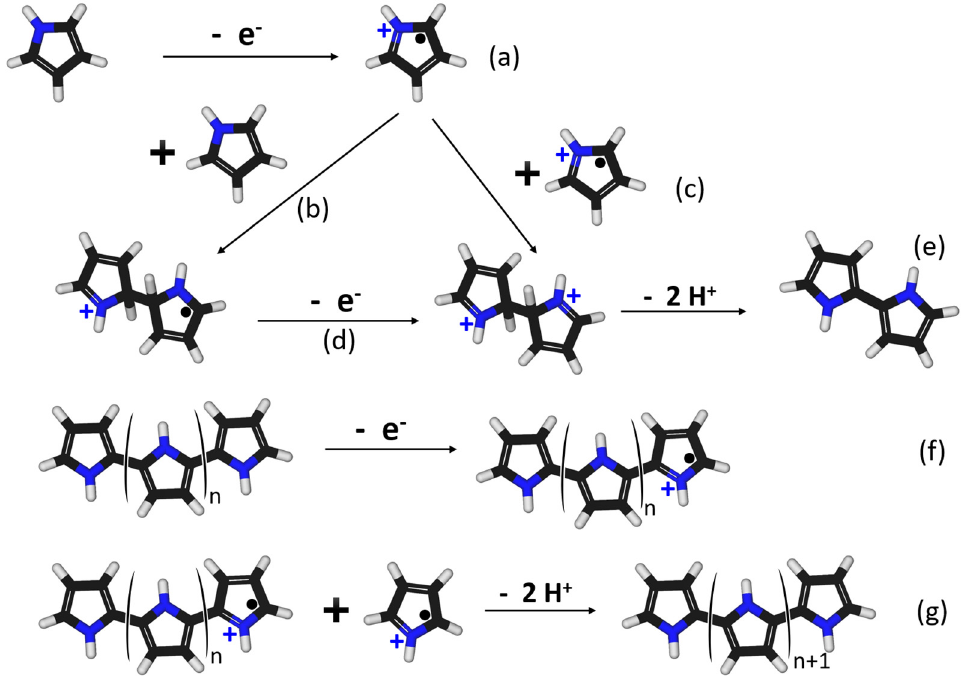
Figure 4. Possible polymerization steps of pyrrole oxidative polymerization in various media; Initiation: ( a – e ), propagation : ( f ), termination : ( g ).